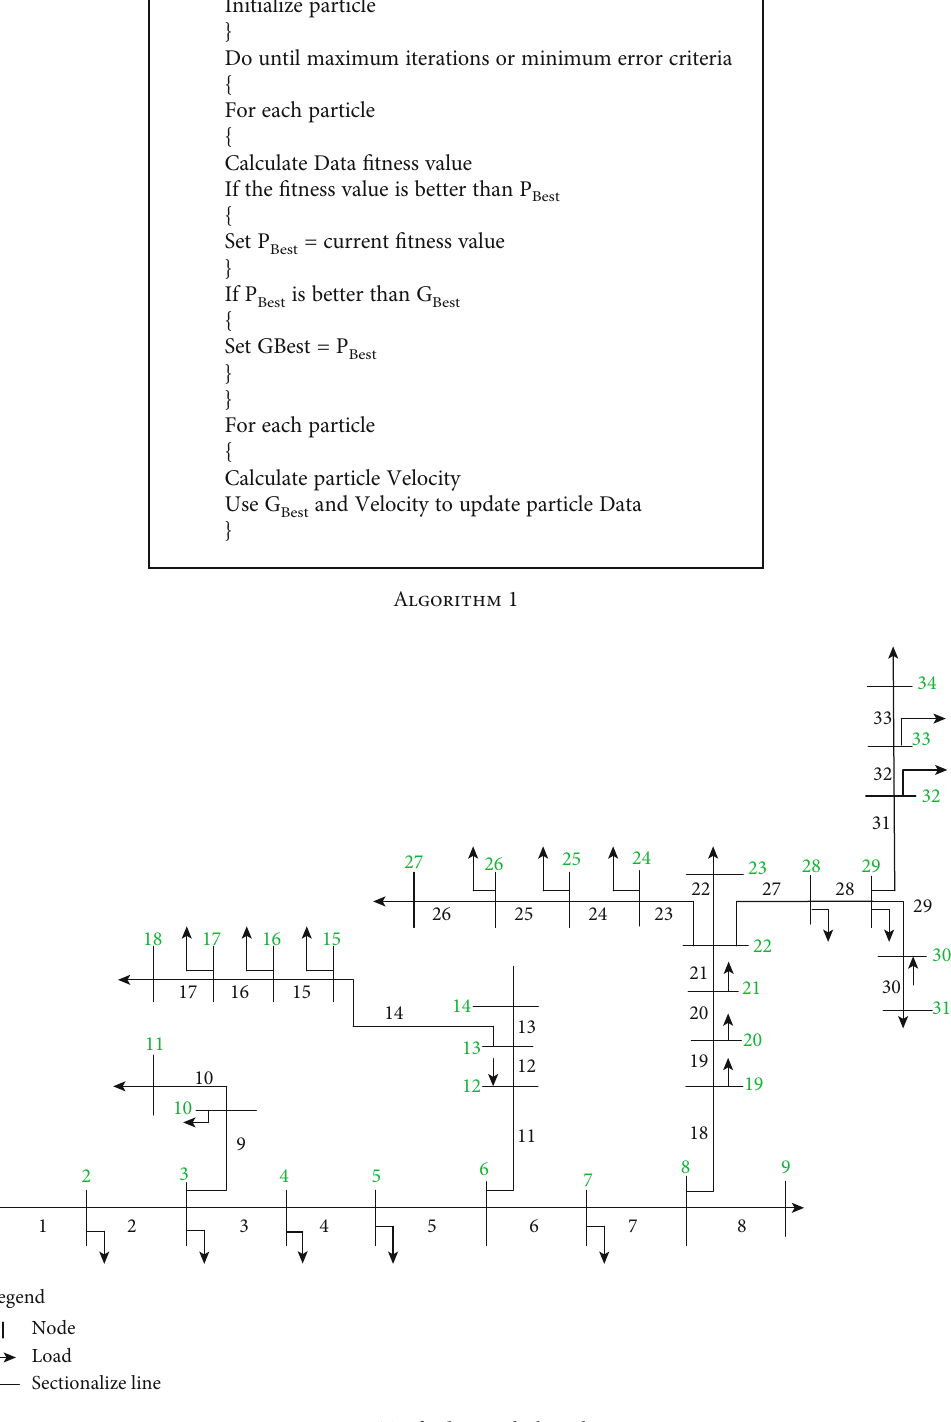
Figure 4: BATA feeder single-line